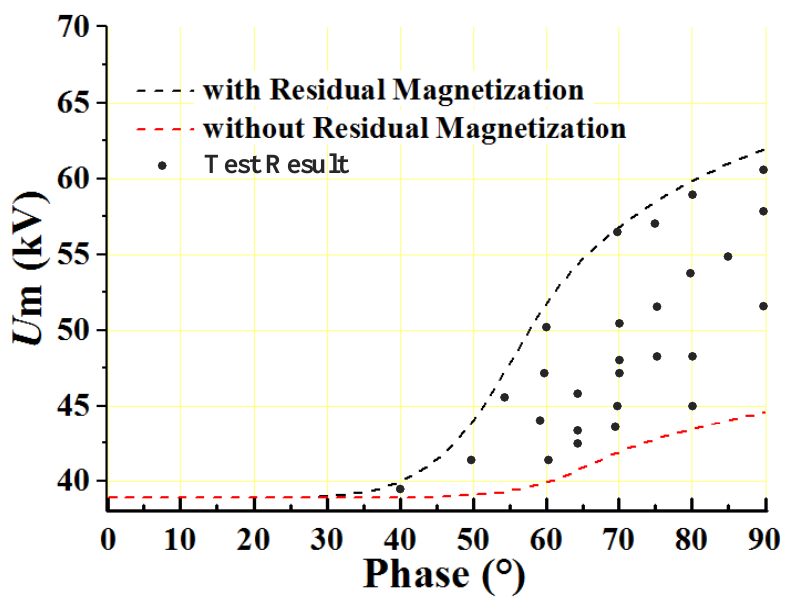
Figure 18. Operational overvoltage test results. The circuit breaker has an obvious restrike in the closing process as shown at points a, b, c and d in Figure 19 with randomness. Multiple reignitions occur in severe conditions.